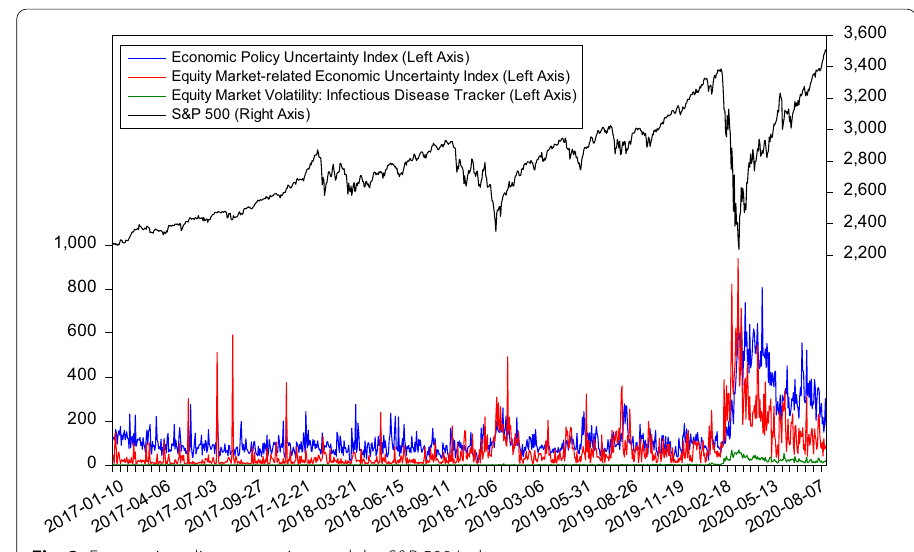
Fig. 2 Economic policy uncertainty and the S&P 500